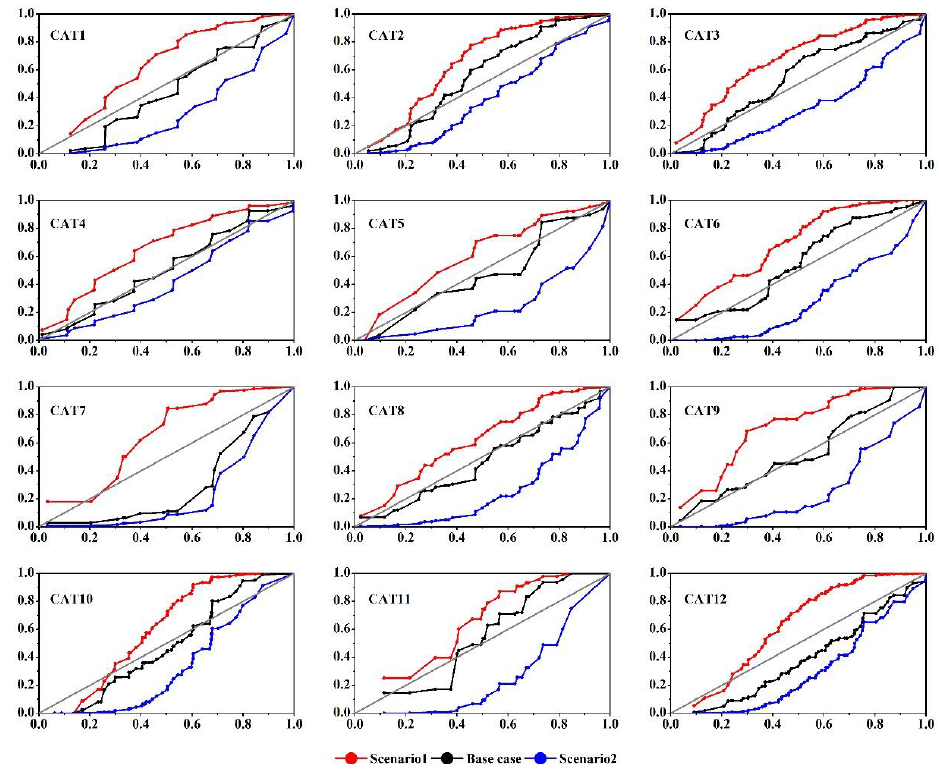
Figure 6. Impervious Area Curves ( IAC ) of the twelve catchments for different scenarios. X -axis represents the fraction of flow distance to the catchment outlet; Y -axis represents the accumulate fraction of the Total Impervious Area ( TIA ). Grey solid lines represent the uniform distribution of TIA in ideal state.